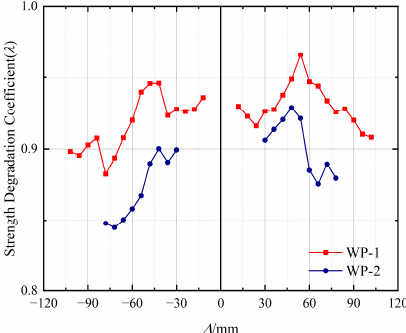
Figure 13. The strength degradation coefficient.